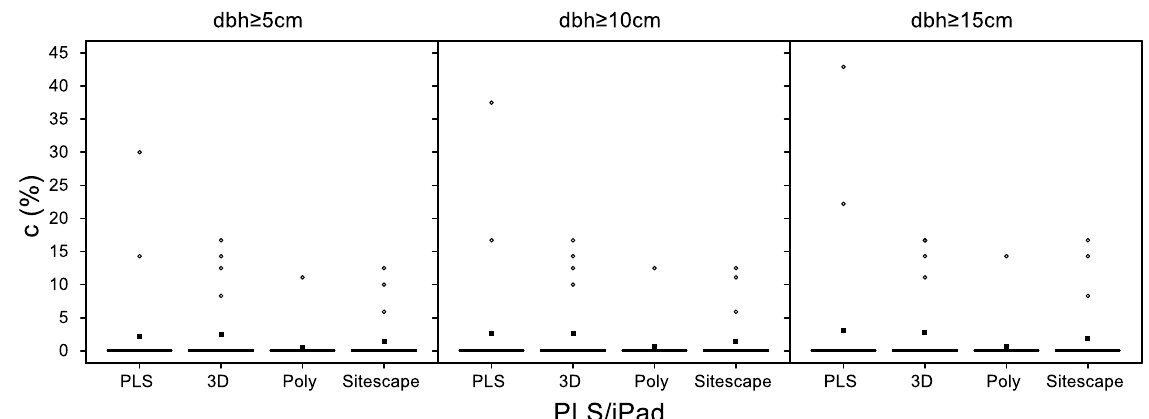
Figure 10. Distribution of commission errors for PLS/iPad and lower dbh thresholds. Black squares represent average